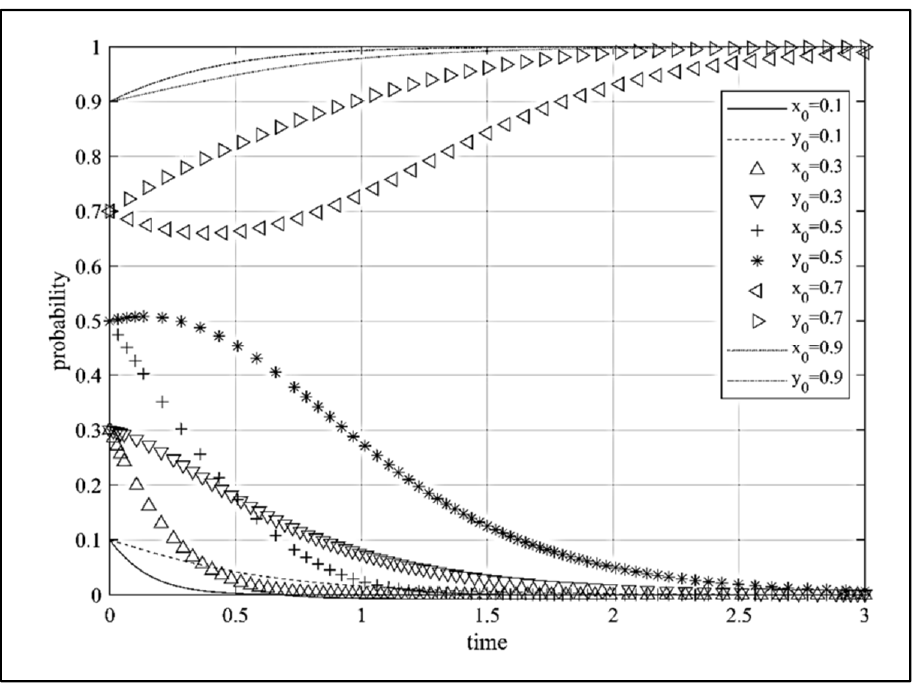
Figure 4. Evolution paths of global warming and local extreme cold game with different initial probability values.